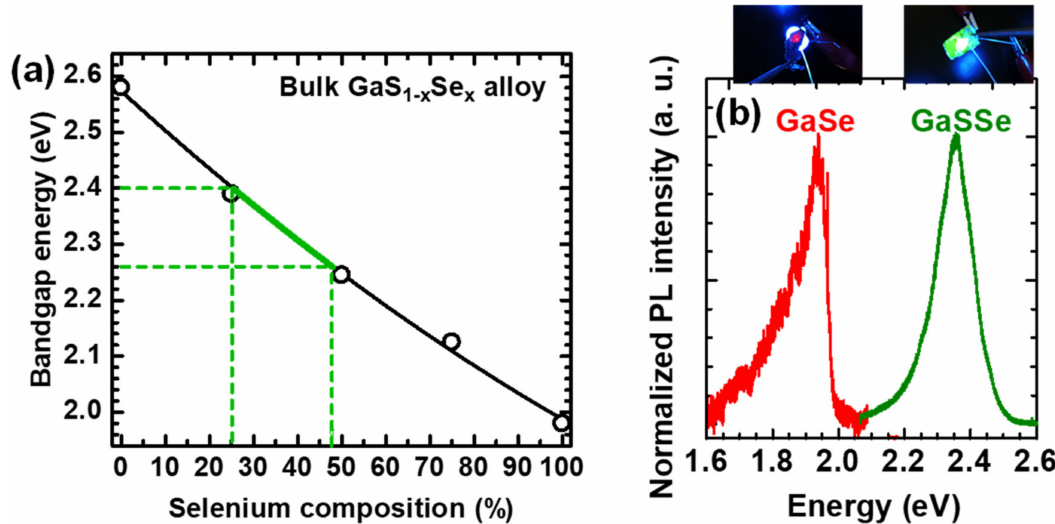
Figure 2. ( a ) Sulfur (S) and selenium (Se) composition dependence of bandgap energy for layered GaS 1 − x Se x alloy. The bandgap energy covering the green emission is realized with the Se of composition x between 25% and 48%. The red emission is achieved by GaSe ( x ~ 100%). ( b ) Photoluminescence (PL) spectra of GaS 0.65 Se 0.35 and GaSe films using blue LED as an excitation source. The inset photographs provide PL images of GaS 0.65 Se 0.35 and GaSe films. The thicknesses GaSSe and GaSe were 400 and 150 µ